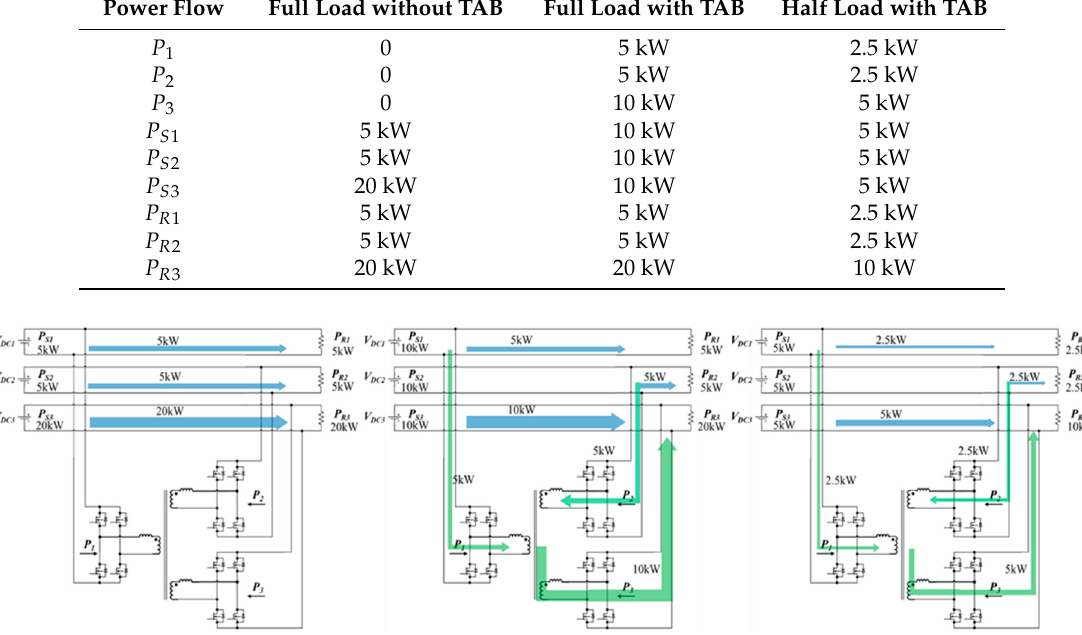
Figure 7. Power flow diagram for the three simulation periods. Table 2. Simulation parameters for the 380-V TAB converter used in the DC power distribution system.